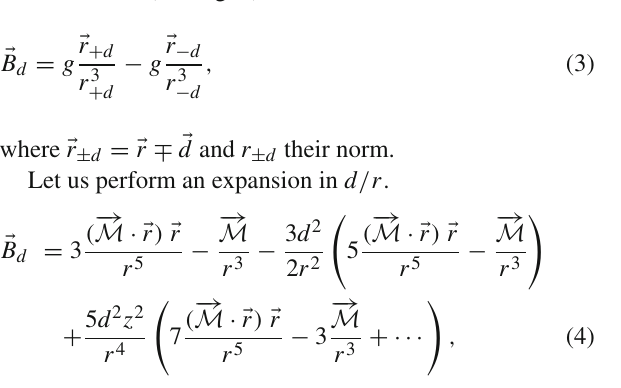
where g is the magnetic charge, (cid:2) r the radial vector of coordi- nates ( x , y , z ) and r the norm of (cid:2) r . Let us construct the mag- netic field of a monopole, located at position and an anti-monopole (located at position ( 0 , 0 , − d ) ), where d is a distance (see Fig.